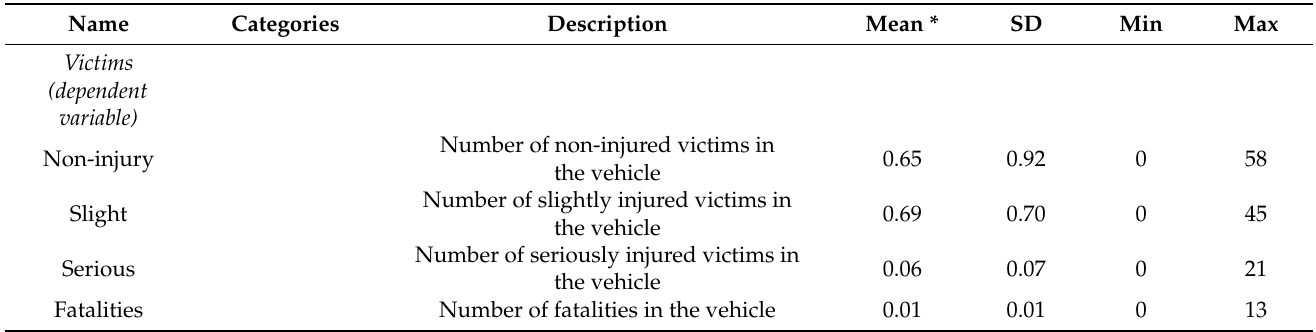
Table 2. Description of